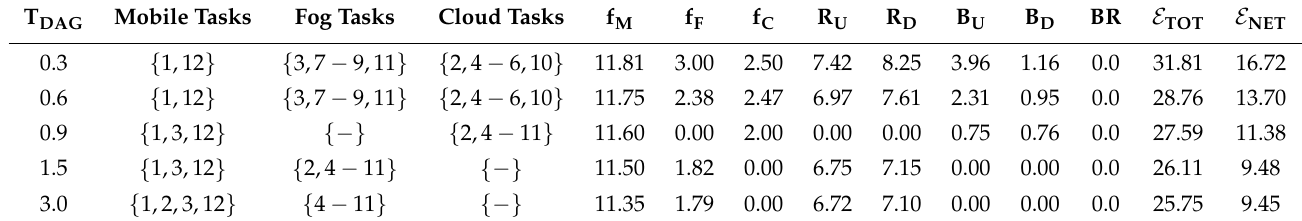
Table 6. Task, resource allocation, and energy consumption returned by GeneticTA_par under DAG1. Resources are measured in Mbit/s and energies in Joule.